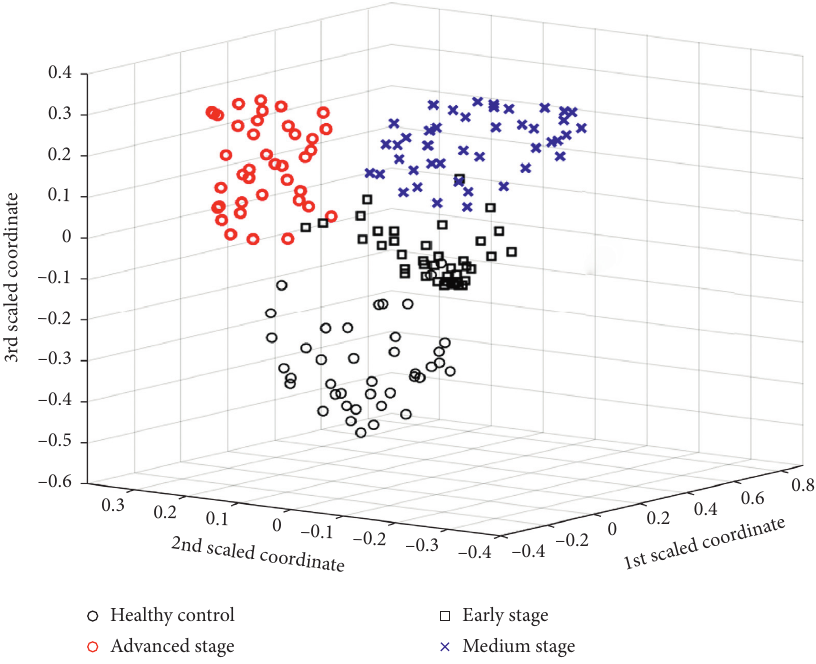
Figure 3: Analysis results of four group samples with random